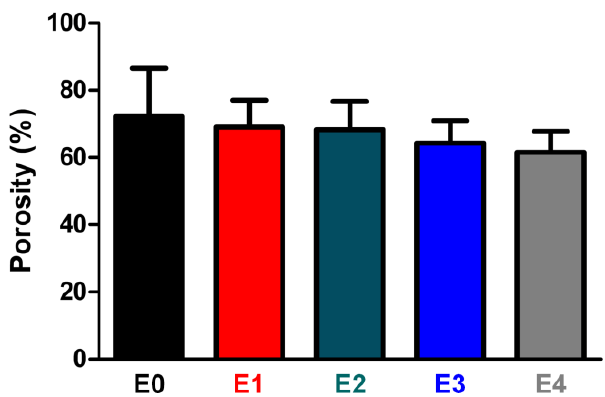
Figure 7. Porosities of ESM/GG hydrogels containing different amounts of ESMs. Error bars mean the standard deviation (n = 4).